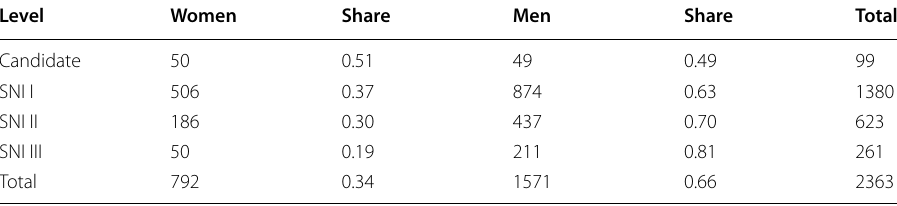
Table 12 Number of women and men in each Level: sample